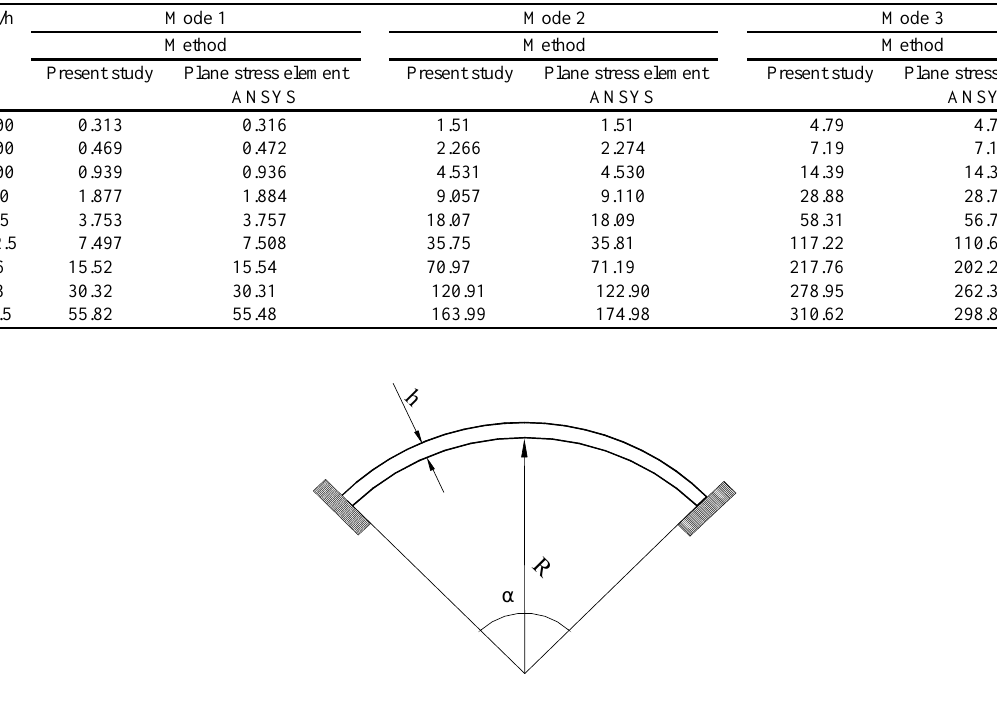
Fig. 6. A thick circular arch clamped at both ends with subtended angle α .